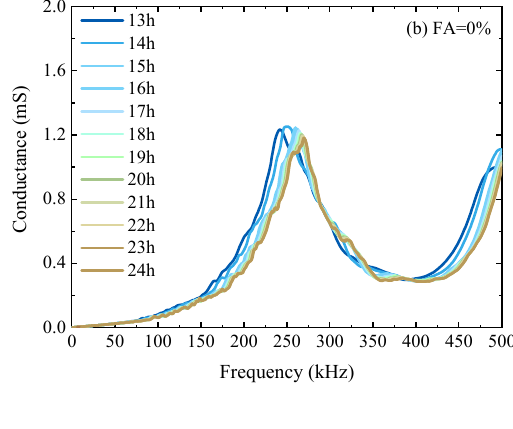
Table 3. Setting times for SCC specimens with different FA replacement ratios predicted by pene- tration resistance tests.